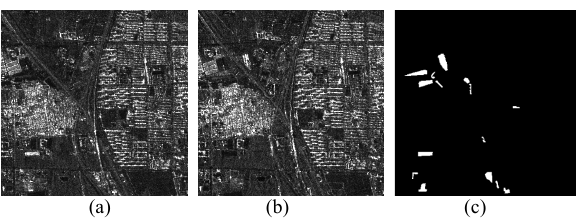
Figure 4. Luchengxiang dataset. (a) Image acquired in April 2017. (b) Image acquired in May 2018. (c) Reference image. Area C - the Weishanzhuang area - has a size of 248×215 pixels, where changes are primarily caused by the update of construction. Images are displayed in Figure 8.